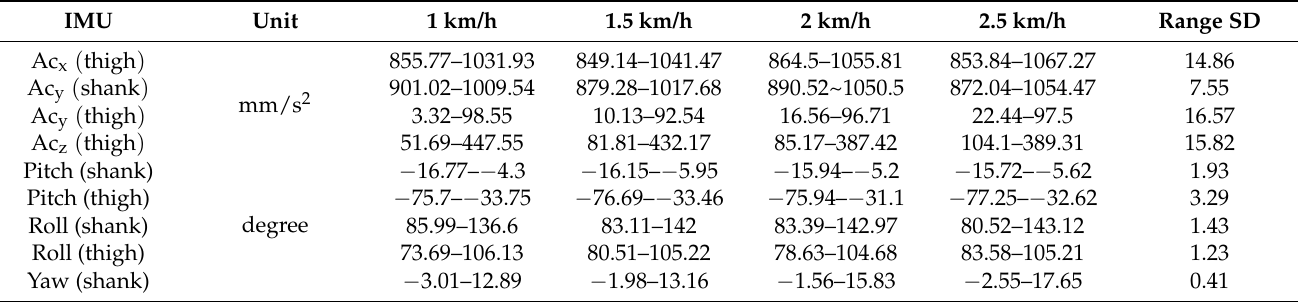
Table 2. Accelerometer and gyroscope data according to the walking